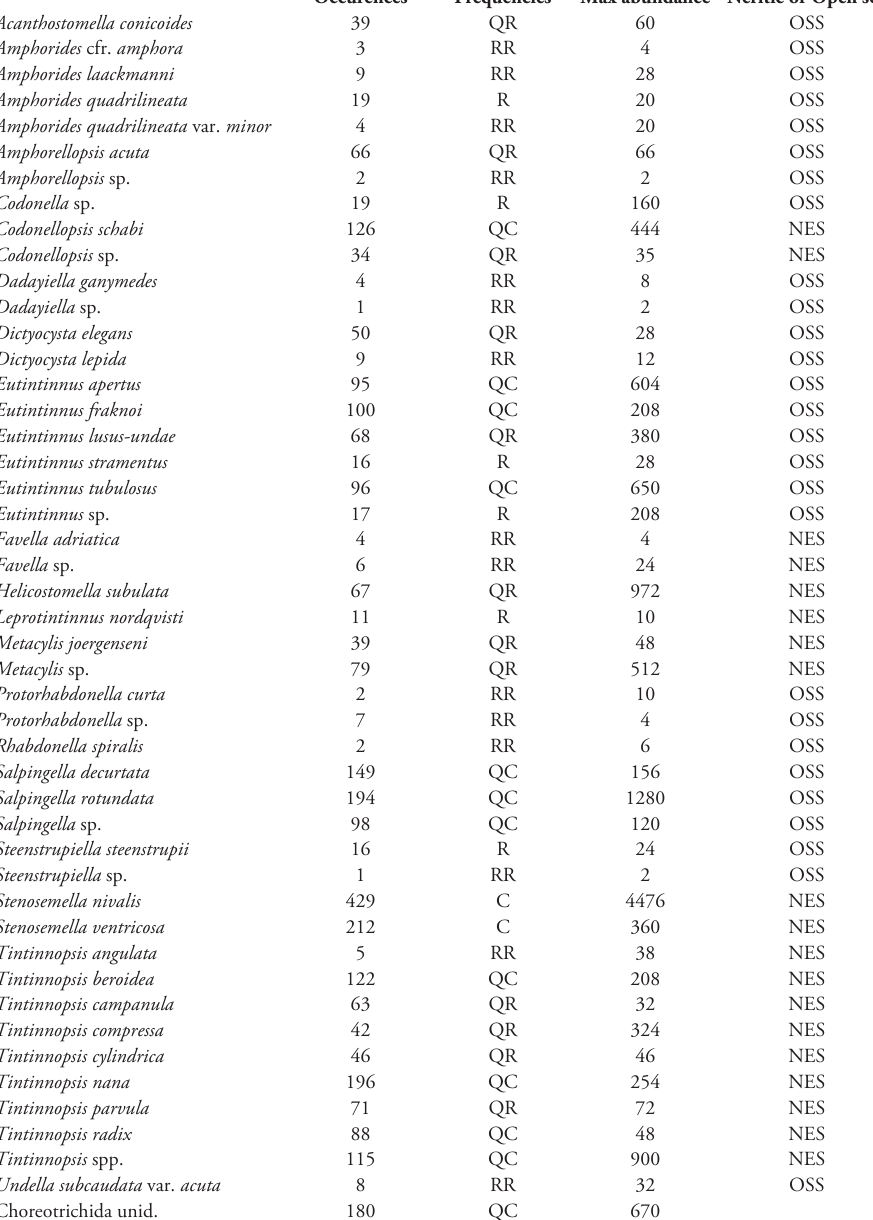
Table 2. Occurrence (number of samples in which the species was present), frequency, maximum abun- dance (ind. L -1 ) and distribution of each tintinnid taxon recorded in the Gulf of Trieste between 1998 and 2016 (total number of samples = 1000). C, common (20–100%); QC, quite common (8–20%); QR, quite rare (3–8%); R, rare (1–3%); RR, very rare (<1%), following the classification of Travers